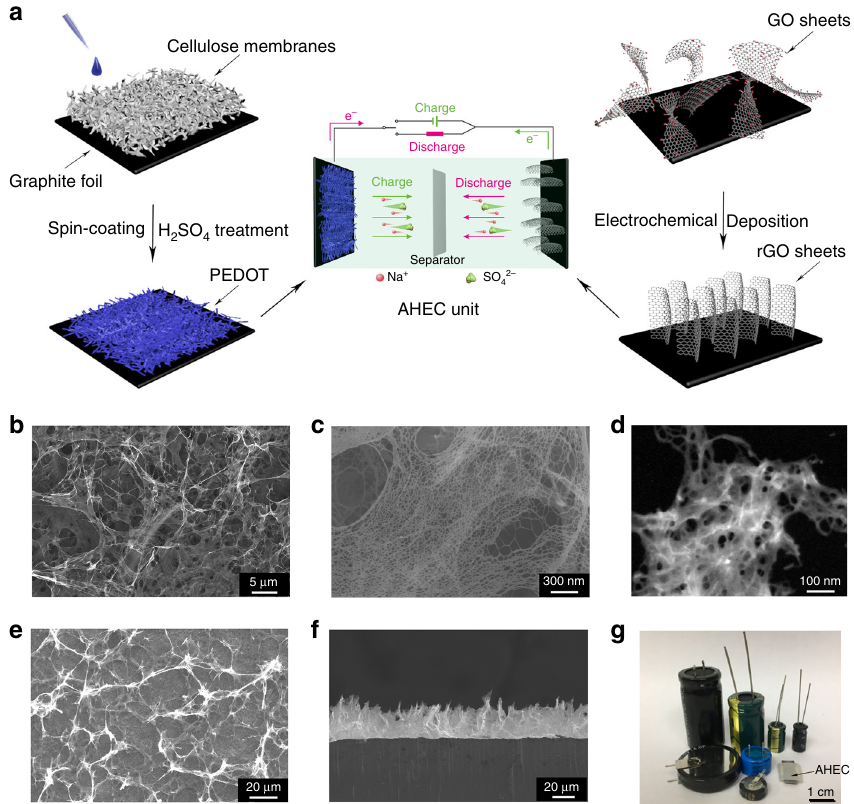
Fig. 1 Preparation and architectures of electrode materials. a Schematic illustrations of the preparation of acid-pretreated poly(3,4-ethylenedioxythiophene) (PEDOT) positive electrode, electrochemically reduced graphene oxide (ErGO) negative electrode, and the assembly of aqueous hybrid electrochemical capacitor (AHEC), and GO represents graphene oxide. b , c SEM images of the PEDOT positive electrode with different magni fi cation, respectively. d High- Angle Annular Dark Field TEM image of PEDOT positive electrode. e , f Top and cross-section SEM images of ErGO negative electrode, respectively. g Photo of the AHEC unit and various commercial aluminum electrolytic capacitors (AECs)